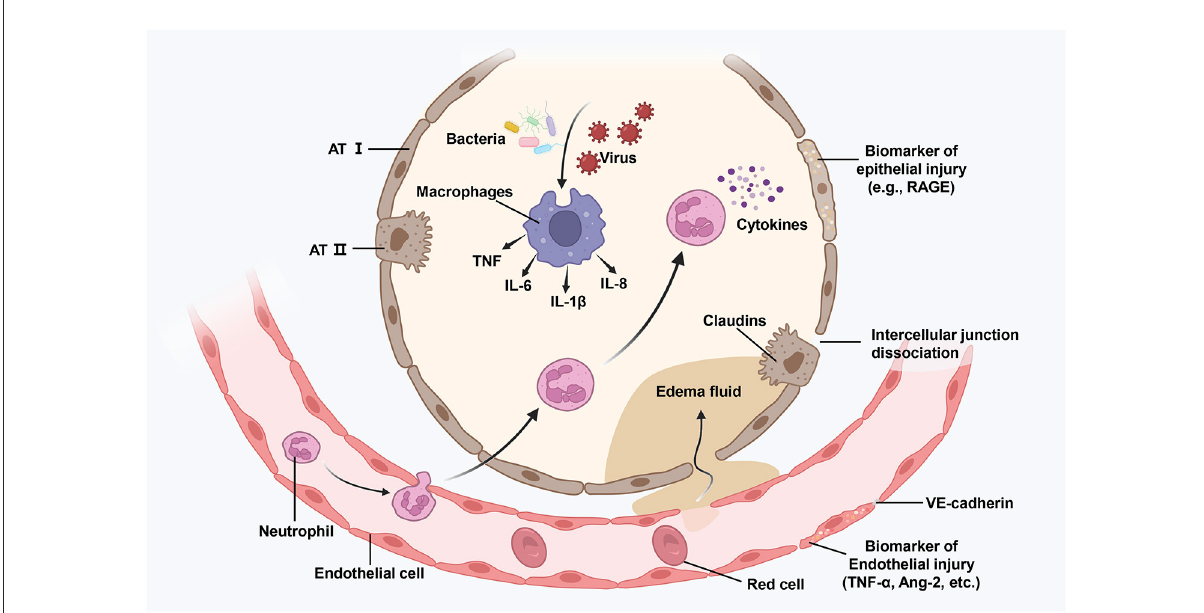
FIGURE1 Illustration of an injured alveolus. Various damage factors (such as attack by bacteria and viruses) can directly or indirectly cause damage to the distal alveolar structure and the related microvascular regions. During the exudative phase, alveolar macrophages get activated, resulting in the release of powerful pro-inflammatory mediators and chemokines (such as TNF, IL-6, and IL-8) that promote the accumulation of neutrophils and monocytes. Activated neutrophils (such as cytokines) further promote damage by releasing toxic mediators. The resulting damage causes the loss of barrier functions as well as interstitial an intra-alveolar flooding. ATI, alvcolar type I cell; TNG, tumor necrosis factor; IL-6, interlcukin-6; Ang-2, angiopoietin 2; RAGE, receptor for advance glycation end-products.